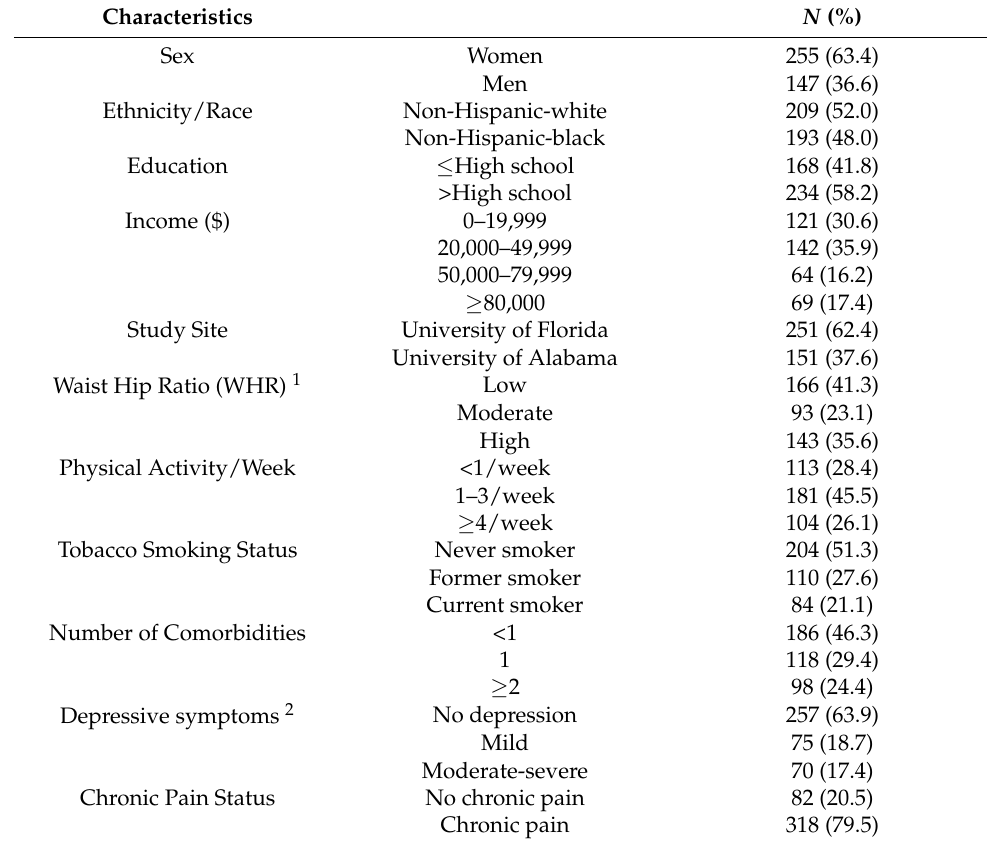
Table 1. Participant characteristics of people with and without chronic pain, N = 402.